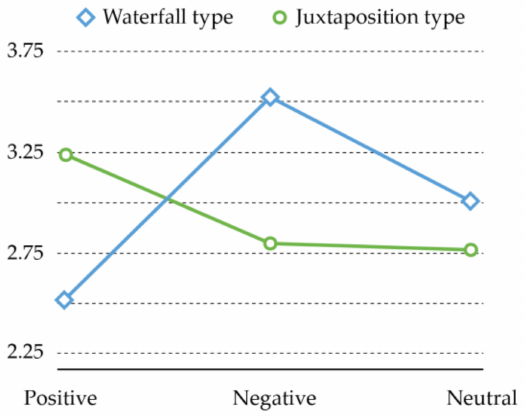
Figure 6. Interaction diagram regarding effort.